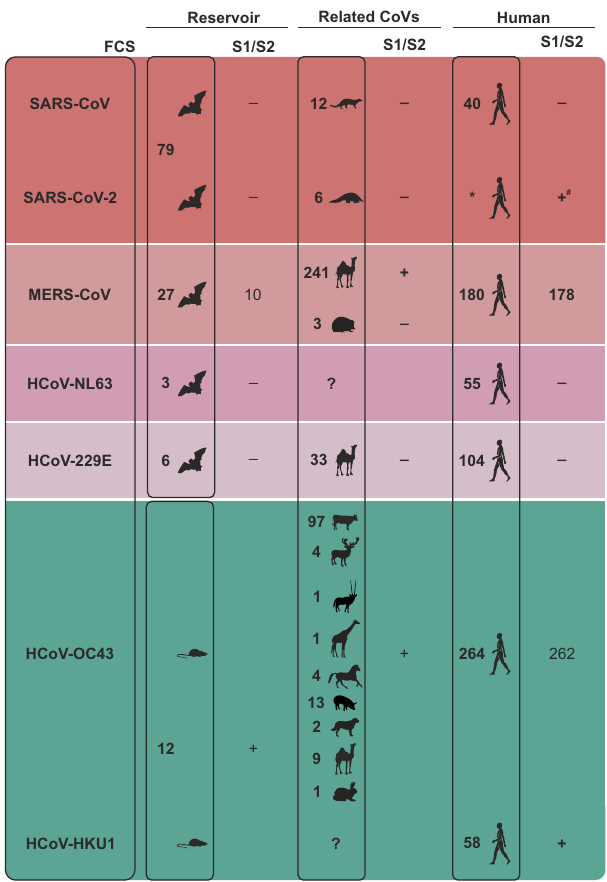
Fig. 3 Furin cleavage sites at the S1/S2 interface in human and related animal coronaviruses. Predicted furin cleavage sites with ProP scores are shown in the Supplementary Data 3. If not all tested sequences of one host category were predicted to contain an FCS, counts are given. *, 4,824,313 SARS-CoV-2 GISAID sequence entries; # 304 SARS-CoV-2 sequences showing a loss of the RRAR furin cleavage site motif.